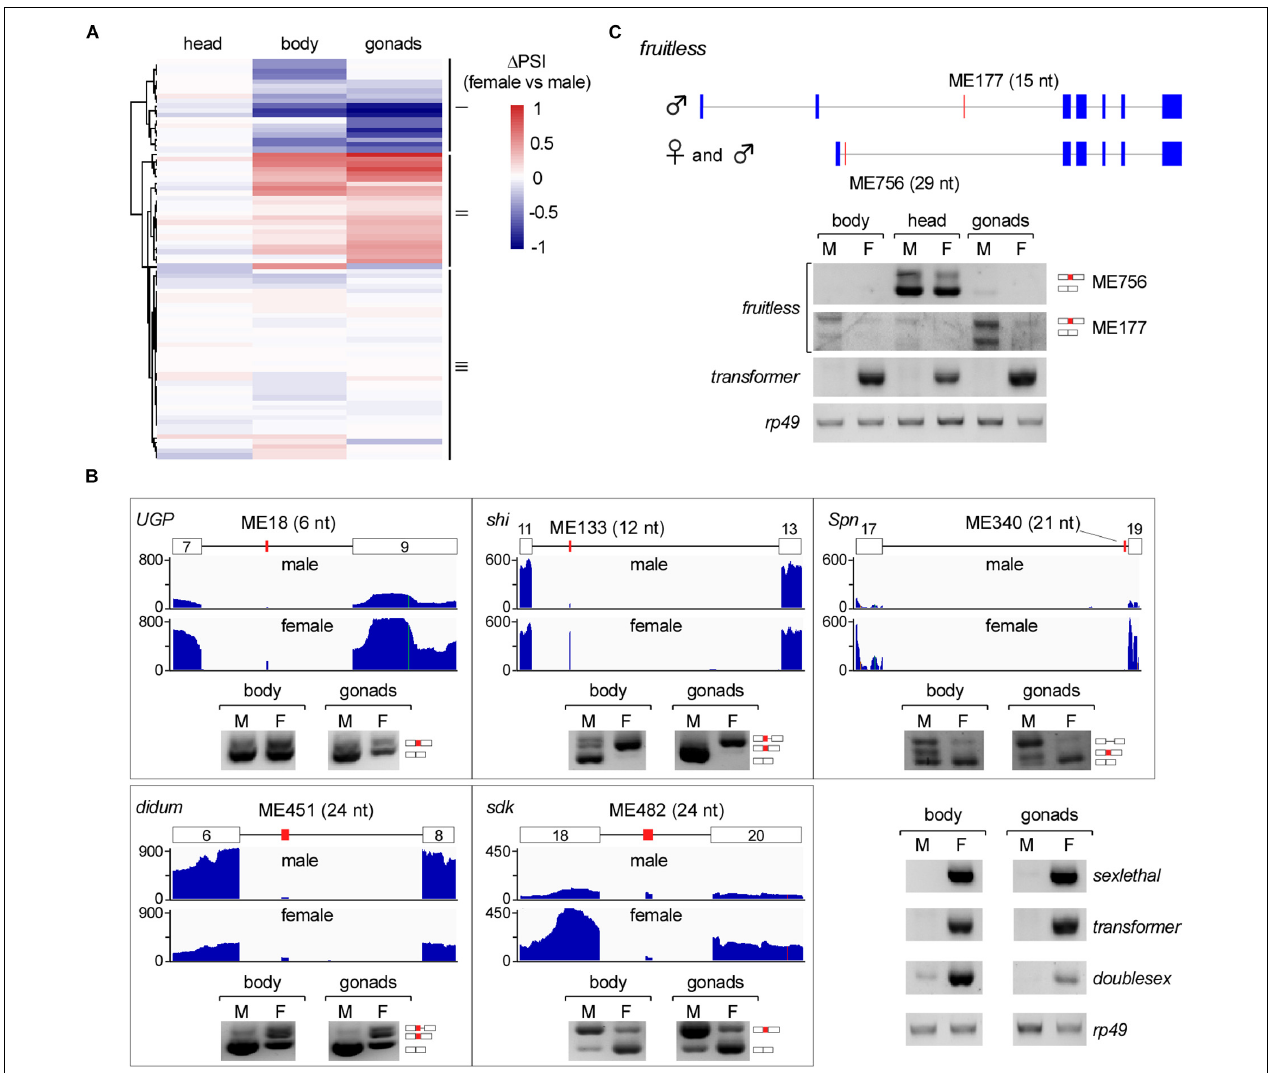
FIGURE 4 | Sex-specific AS of Drosophila microexons. (A) Comparison of differential AS between samples from two Drosophila genders. (B) Validation of sexually AS microexons. Each microexon was validated by amplification of cDNA using two primers located in its flanking exons. Lengths, belonging genes, and names of microexons are indicated. Blank boxes: flanking exons, orange boxes: microexons. Primers information is listed in Supplementary Table 1 . (C) Two microexons in fruitless are alternatively